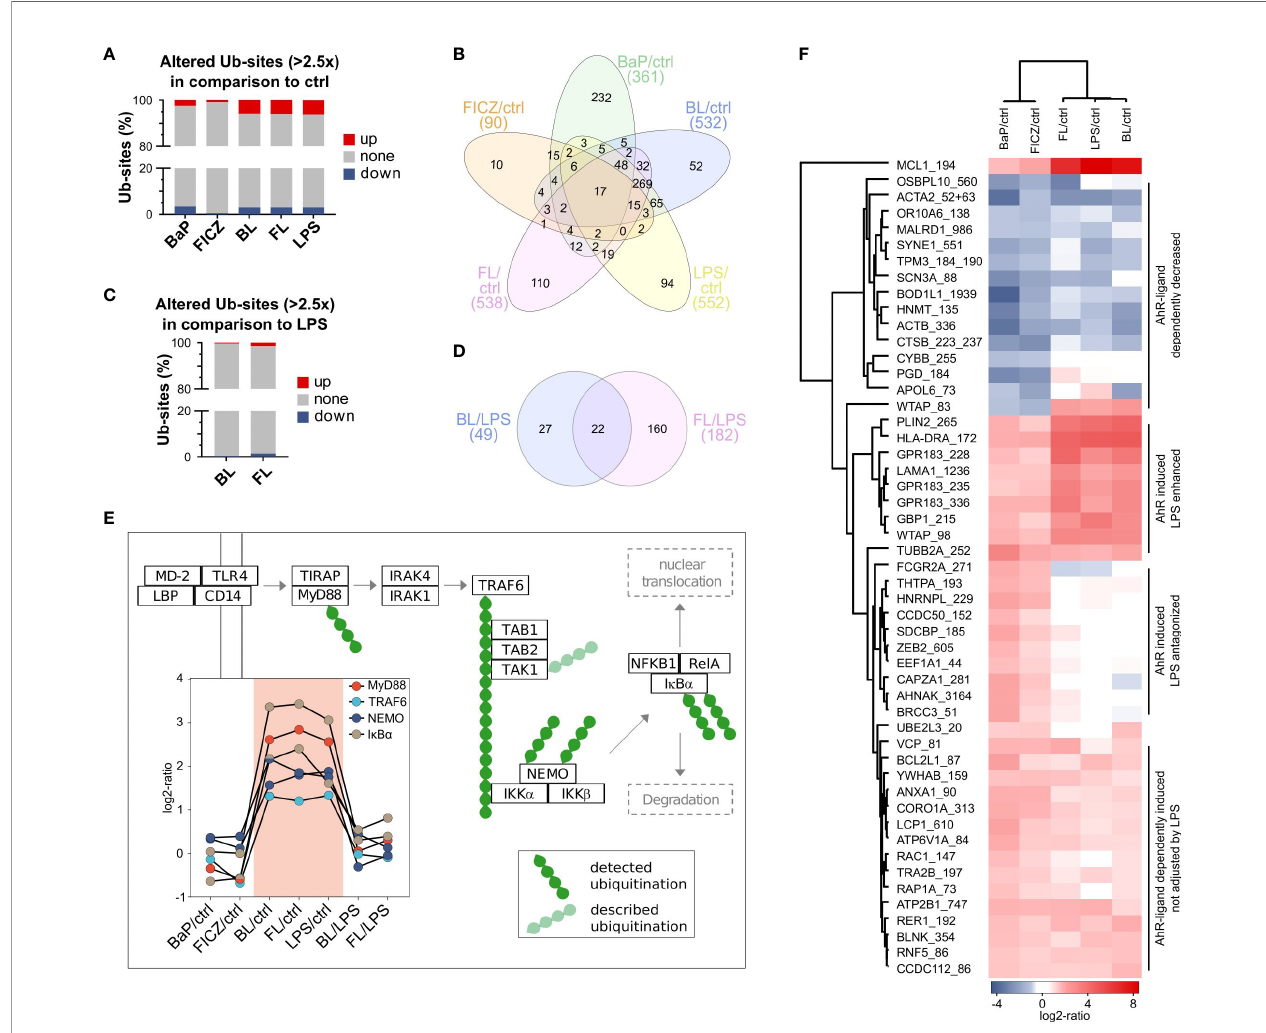
FIGURE 3 | Effect of AhR activation on protein ubiquitination (A) Rates of ubiquitination sites (Ub-sites) with altered abundance after 2h in comparison to untreated control. Ub-sites with a FC ≥ 2.5 and a maximal CV ≤ 50% were considered as differentially abundant. Ubiquitome samples were pooled from 9 donors and measured in duplicates. (B) Overlap of altered Ub-sites between different treatments. (C) Rates of altered Ub-sites in double-treated macrophages in comparison to LPS-treatment. (D) Overlap of altered Ub-sites by AhR-ligands under in fl ammatory conditions. (E) Regulation of ubiquitination in MyD88-dependent TLR4 signaling. Obtained ubiquitome data were searched for proteins described as ubiquitinated after TLR4-activation. Detected Ub-sites are shown in dark-green and described but not detected Ub-sites in pale-green. (F) Ub-sites mutually regulated by BaP and FICZ